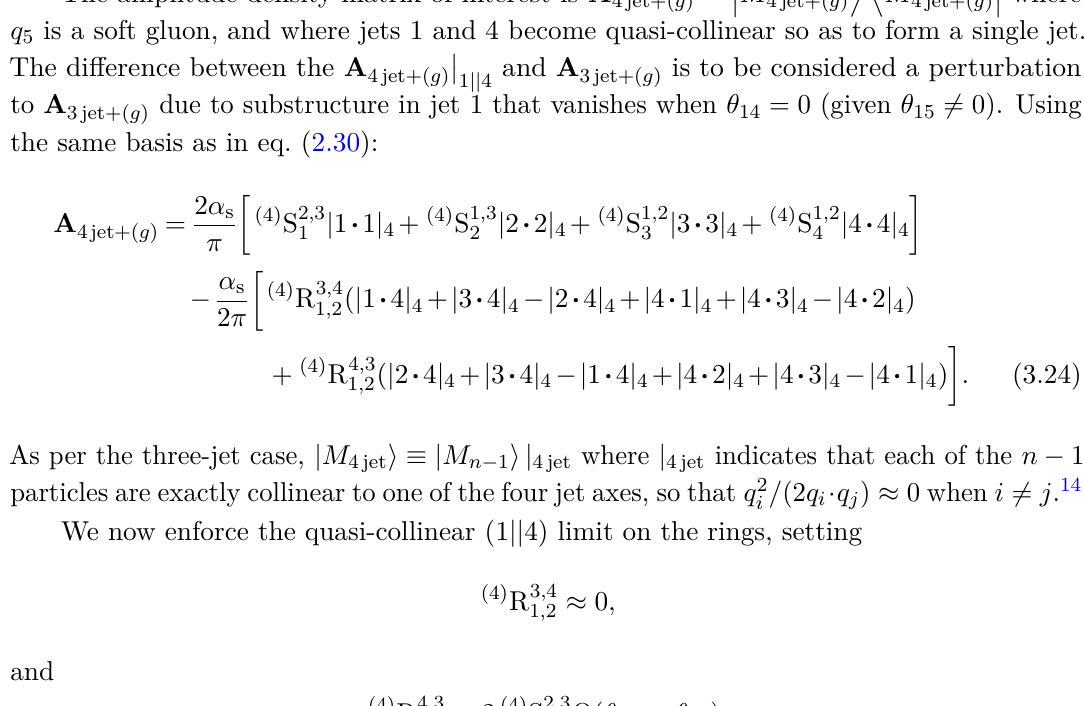
Figure 5 . Contributions to particles and the grey circle represents the hard process. The difference between (cid:12) (cid:11) and is interpreted as being due to substructure in jet (cid:12) M 3jet+( g )